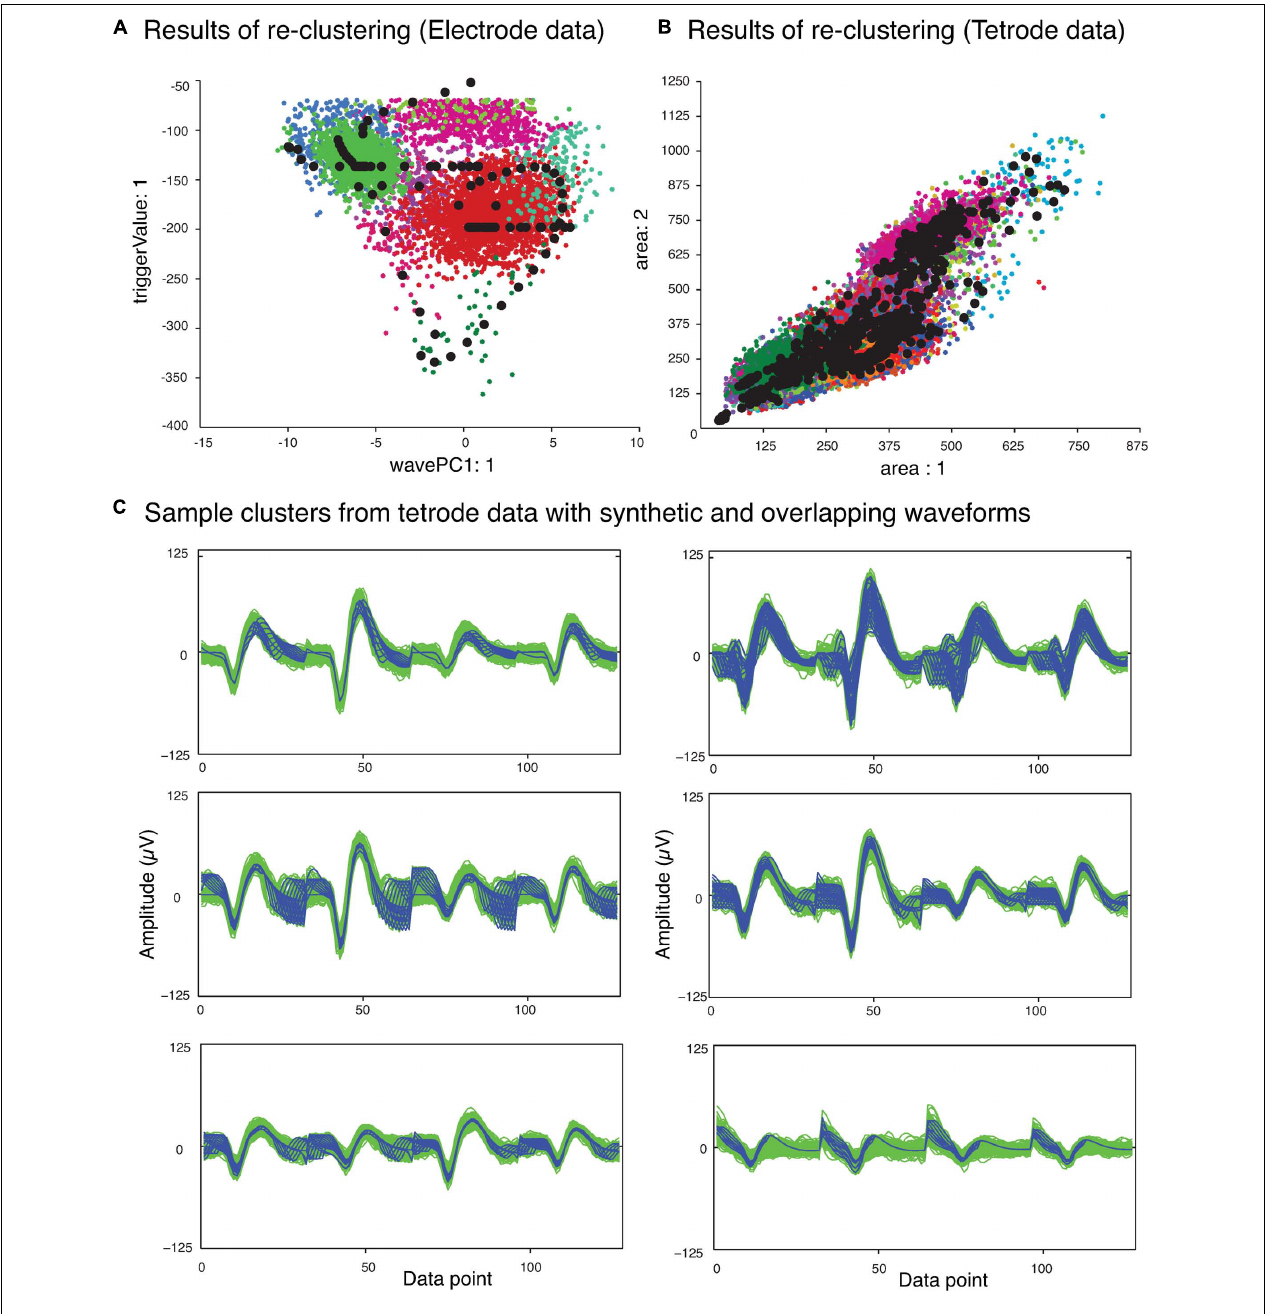
FIGURE 4 | Results of second clustering of data shown in Figure 2 . (A) Electrode data. (B) Tetrode data. Synthetic waveforms are highlighted as black circles. These waveforms were clustered with real overlapping waveforms. (C) Waveforms from six clusters that included both synthetic (blue) and overlapping waveforms (green) for the tetrode data. Two distinct minima can be seen on each channel corresponding to the single spikes that contributed to the overlap.